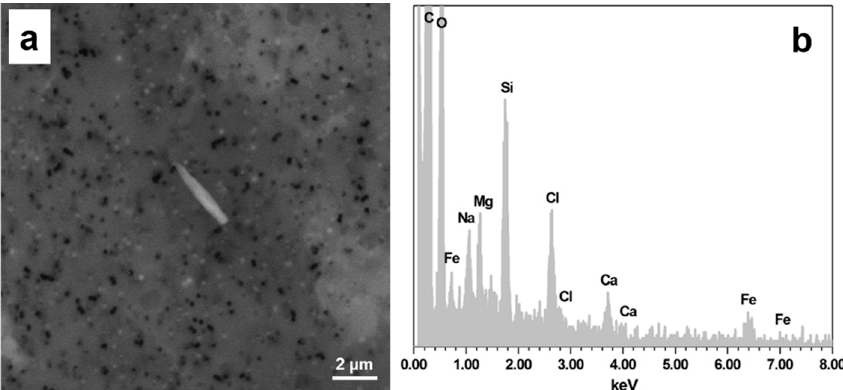
Figure 2. Free fiber observed in digested healthy tissue and relative EDS analysis. ( a ) Small fiber observed in the healthy tissue. ( b ) EDS spectrum acquired on the fiber in ( a ); the chemicals and the relative intensities of the peaks identify tremolite/actinolite, minerals regulated as asbestos. Na and Cl peaks are ascribed to NaCl crystallization during the digestion process.